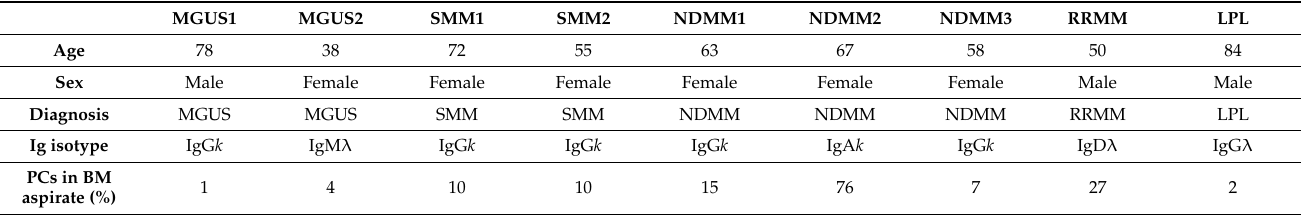
Table 1. Patient demographics and clinical characteristics. FC: flow cytometry, sFLC: